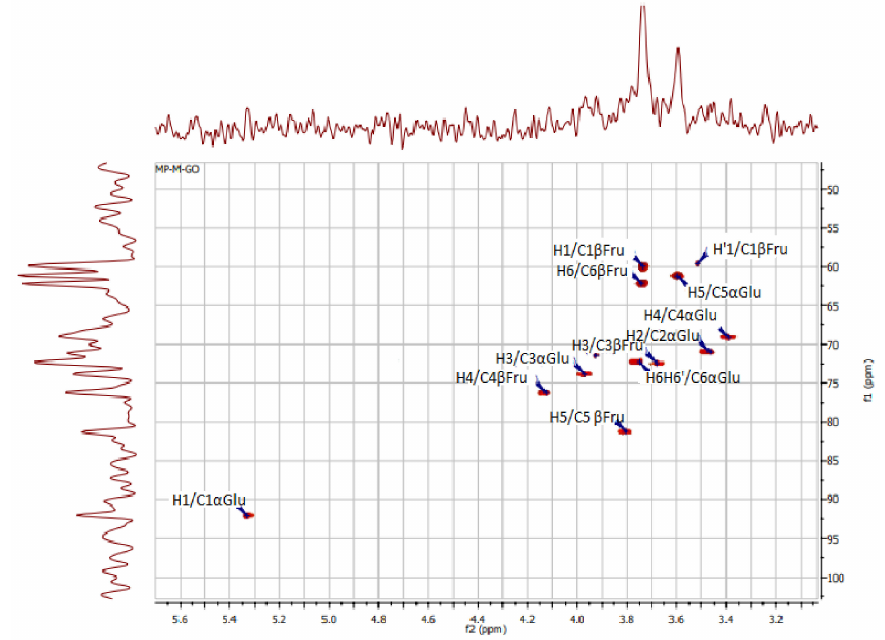
Figure 3. HSQC spectra of polysaccharides from Ceratonia siliqua kibbles. Table 3. HSQC spectrum interpretation of the